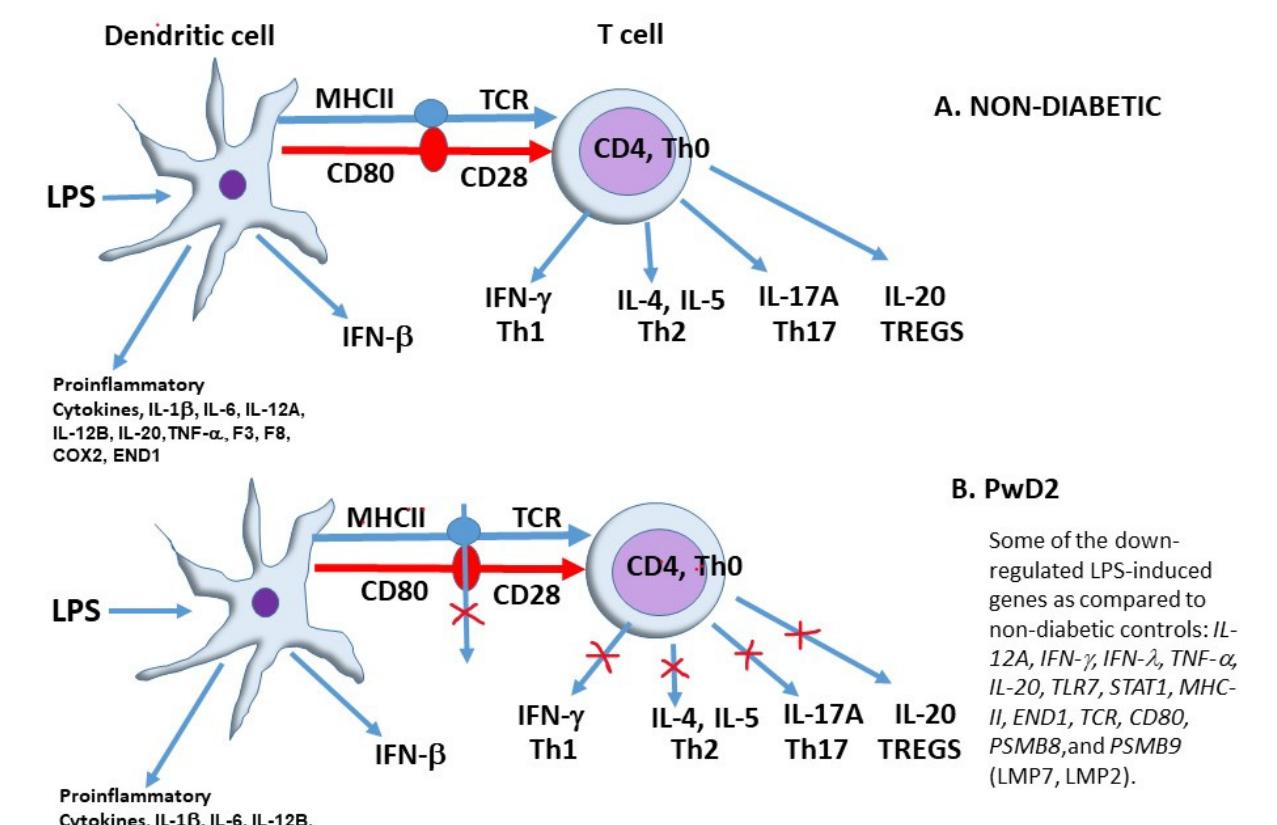
Figure 10. A simplistic model for LPS-induced genes in non-diabetic vs. PwD2. Figure shows the modulation of gene expression in treated PBMCs of PwD2/non-diabetics with RES, LPS, and LEC. Respective controls were used for analyses. A simplistic model for activation of innate and acquired immunity in PBMCs based on LPS-mediated gene expression. The role of RES, LPS, LPS + RES, and LEC10 on the innate and acquired immunity in human PBMCs from non-diabetic controls and PwD2 was determined.